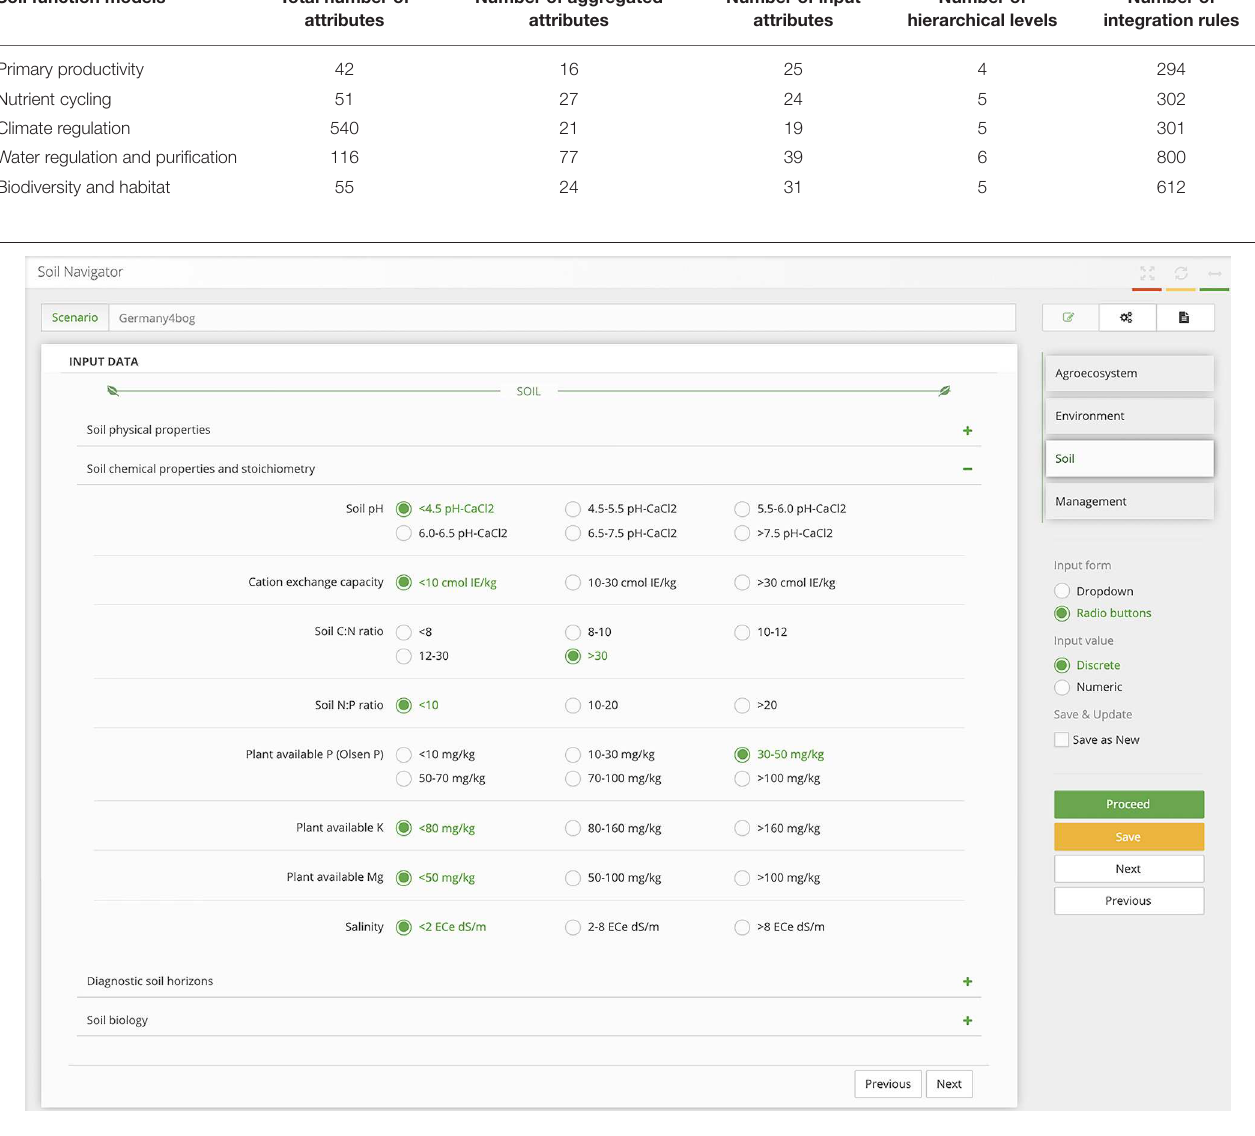
FIGURE 4 | Data entry form for a particular agricultural